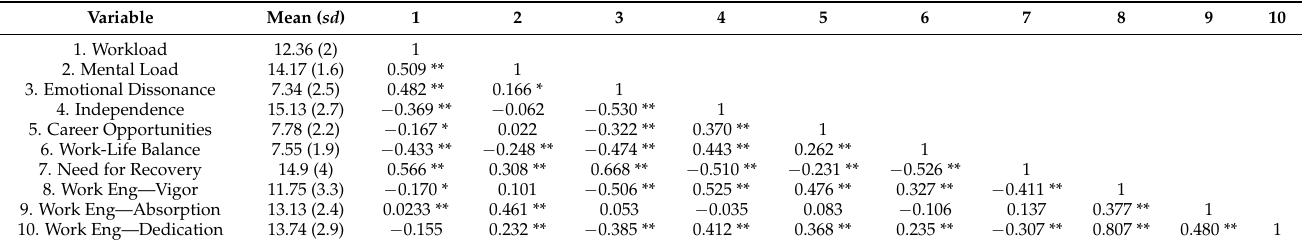
Table 1. Means, standard deviations, and correlations between study variables ( n =